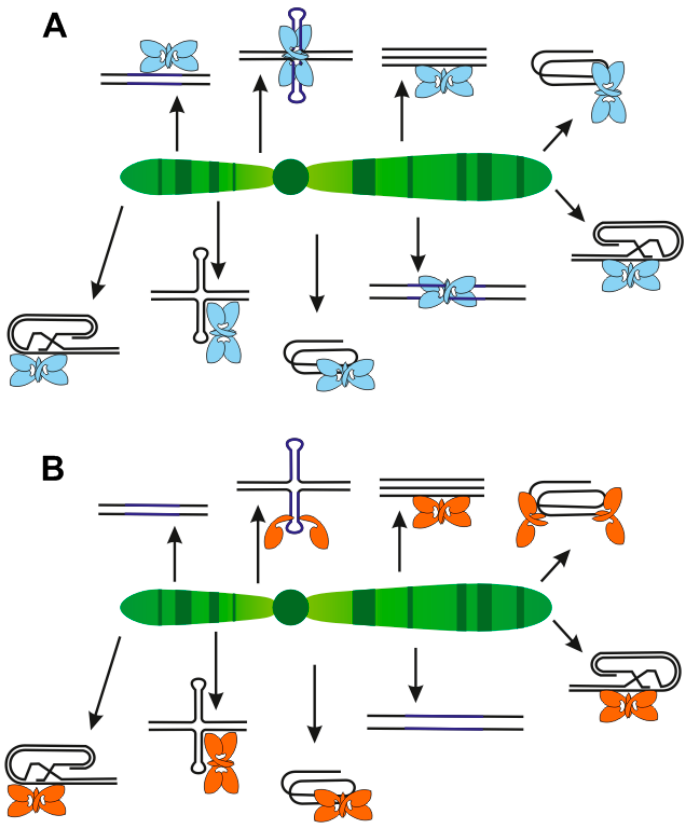
Figure 6. Various targets for wild-type ( A -blue) and mutant ( B -violet) proteins.